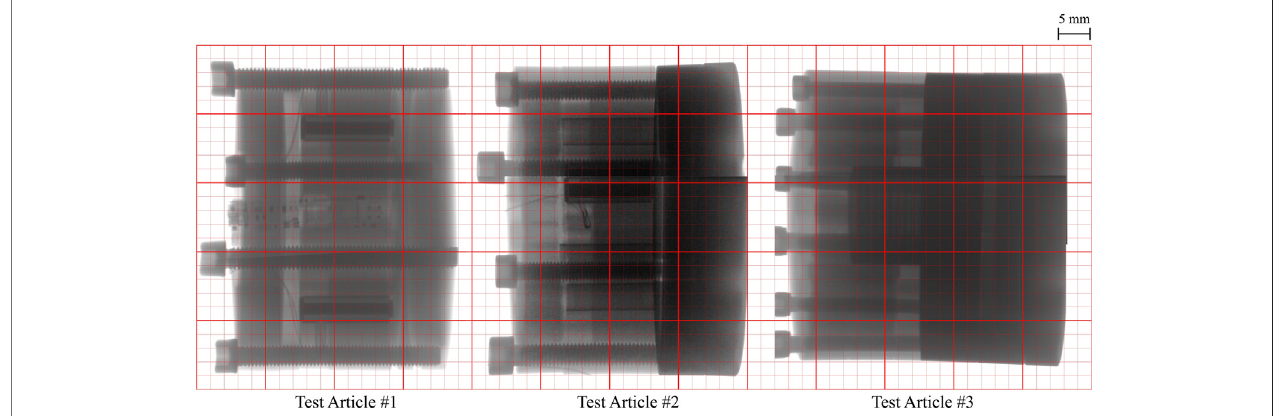
FIGURE 12 | Post-impact test article manifold and bolt alignment